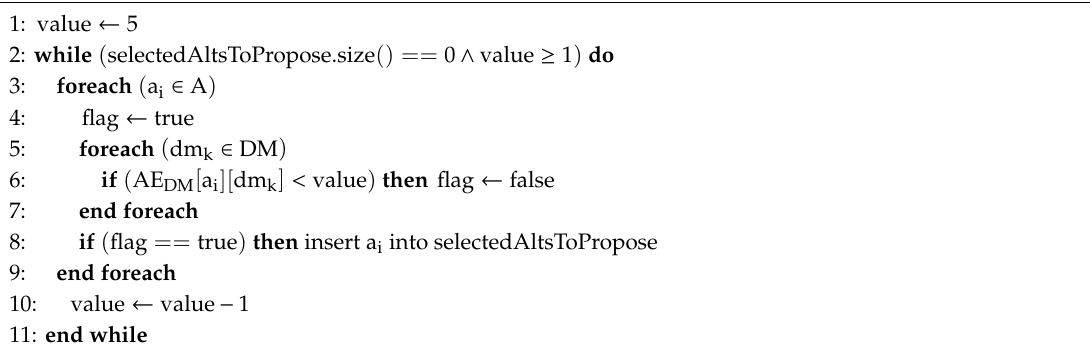
Algorithm 3. Algorithm for selecting the alternatives as candidate